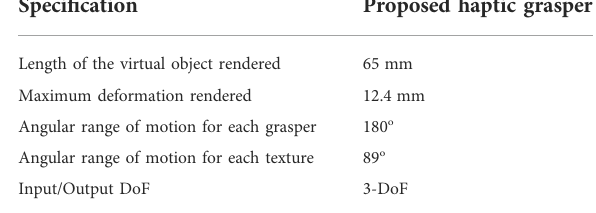
TABLE 4 Speci fi cations of the proposed haptic